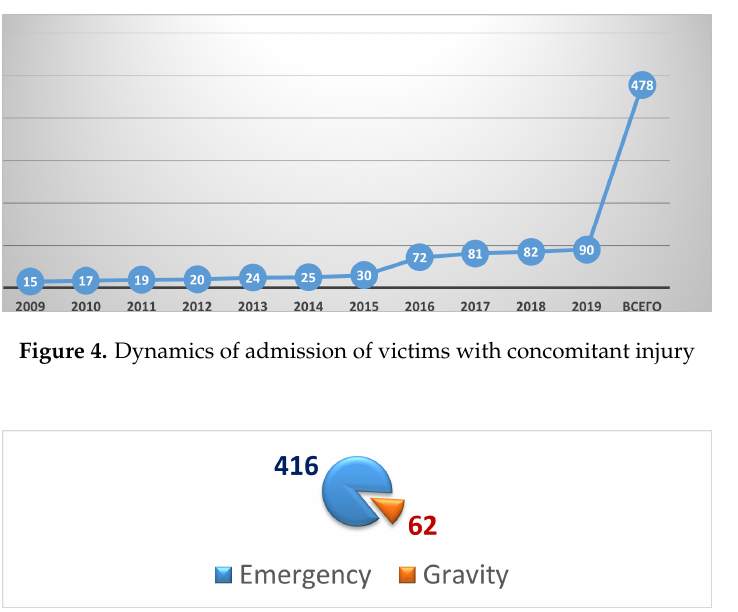
Figure 5. Ways of hospitalization of victims with associated trauma